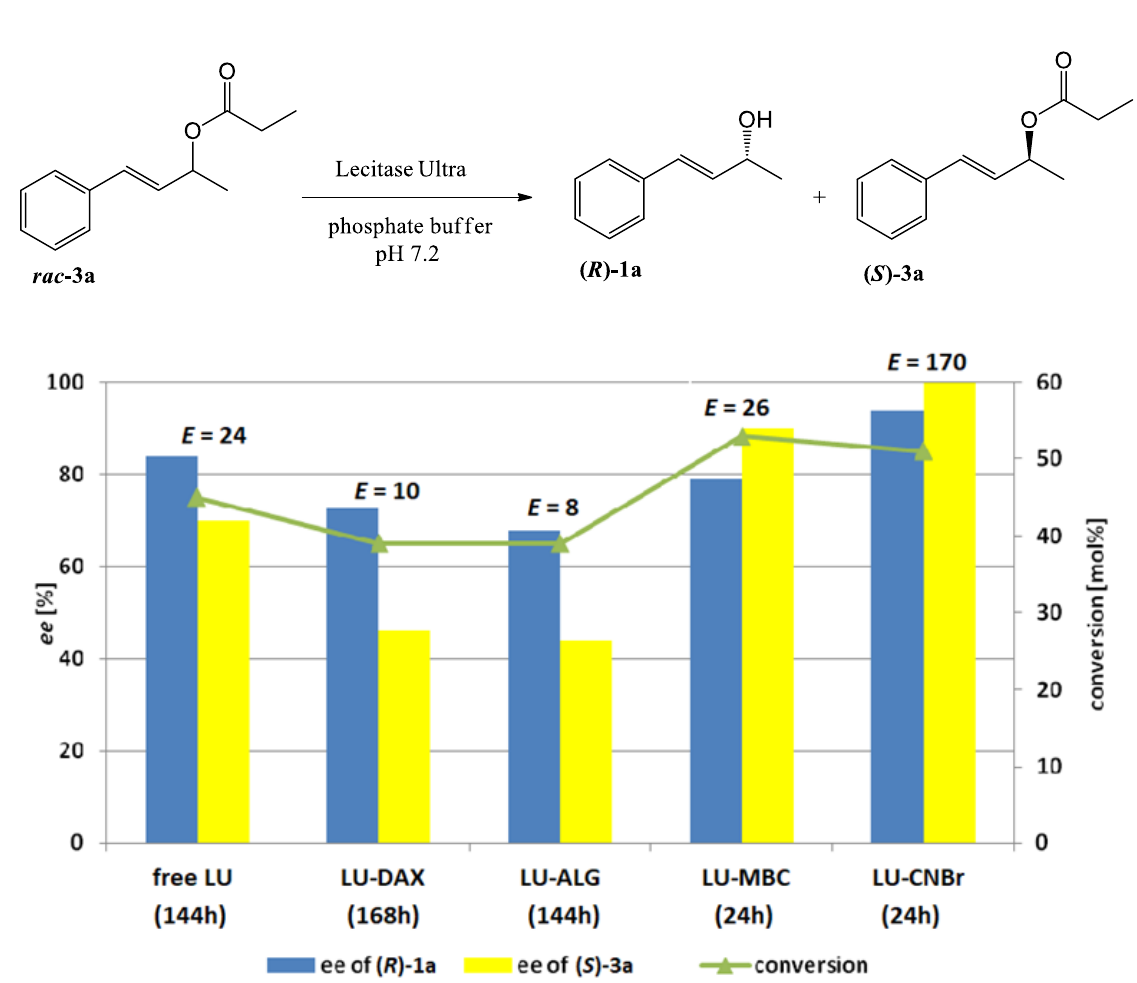
Figure 2. The effect of enzyme immobilization on the conversion, enantioselectivity, and enantiopurity of the products of Lecitase ™ Ultra-catalyzed hydrolysis of racemic propionate 3a (reaction scheme presented above).